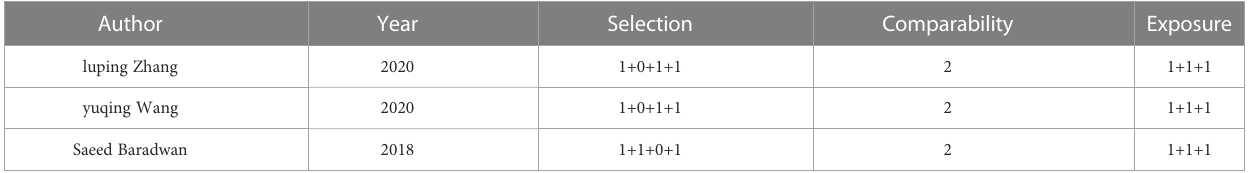
TABLE 1 Risk of bias assessment using the Newcastle-Ottawa Scale (for studies with a comparator